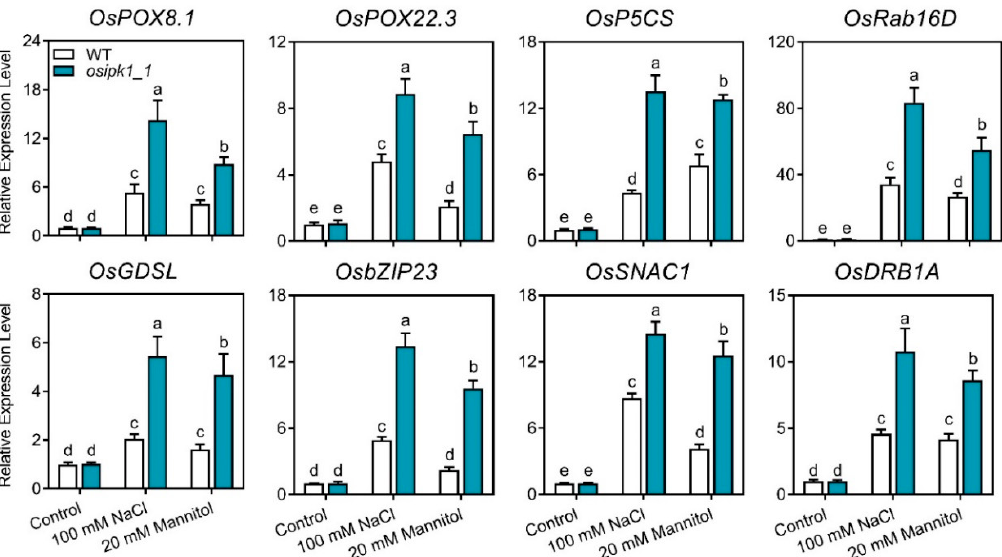
Figure 8. Relative expression level of stress related genes in Xidao #1 (WT) and its OsIPK1 mutant line osipk1_1 . All analyses were performed with three replicates. Error bars represent standard error. The different letters show the significant difference at a probability of p < 0.05. The stress related genes encode various proteins including two peroxidase genes OsPOX8.1 and OsPOX22.3 , proline synthesis protein OsP5CS , rab16 family protein OsRab16D , osmolytes metabolism enzyme OsGDSL , bZIP transcription factors OsbZIP23 , NAC (NAM/ATAF/CUC) transcription factor OsSNAC1 and dehydration responsive element-binding protein OsDREB1A .